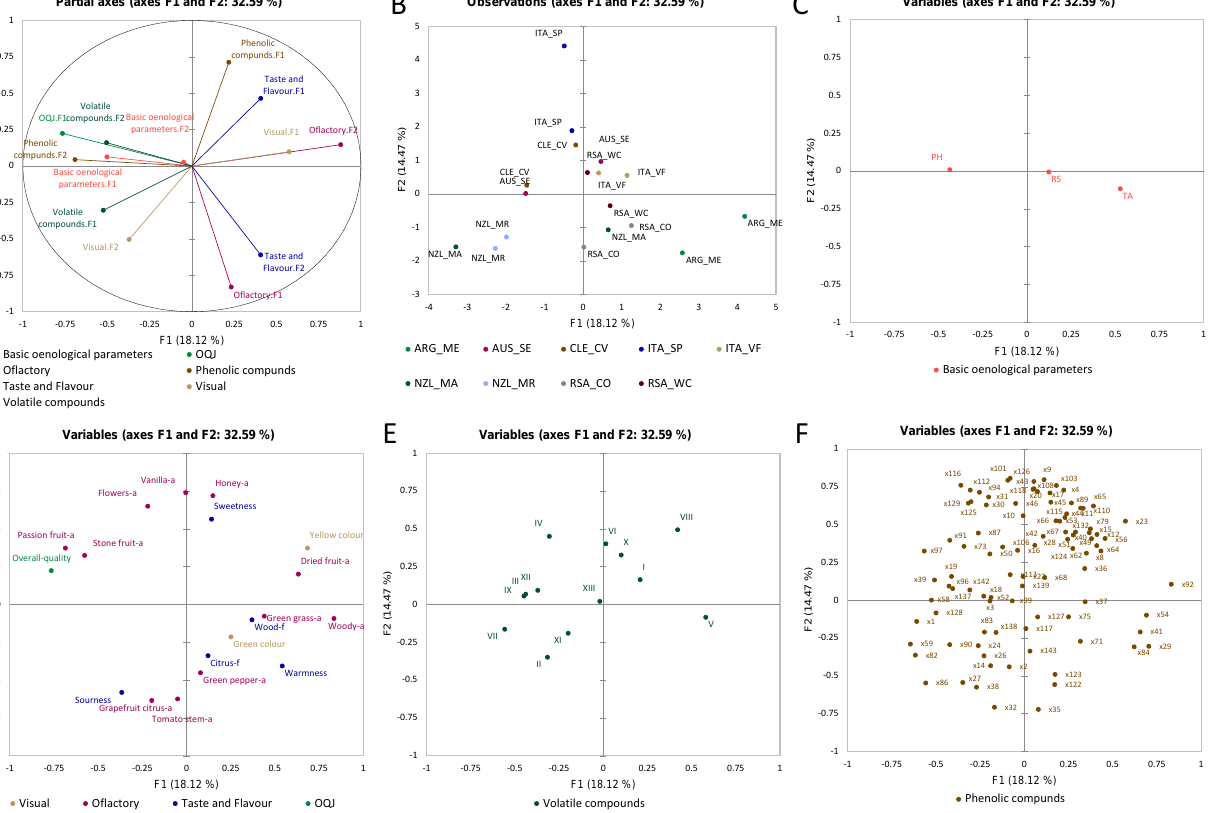
Figure 4. MFA for Sauvignon Blanc dataset. ( A ) shows the partial axes for the first 2 compo- nents and different datasets used in the computation. ( B ) shows the observation plot and ( C – F ) shows basic oenological variables, sensory analysis variables, aroma compounds, and phenolic compounds, respectively. Volatile compounds: I = 1-octen-3-ol, II = 2-sec-butyl-3-methoxypyrazine, III = 3-mercapto-hexanol, IV = 3-mercapto-hexyl acetate, V = 4-mercapto-4-methyl-2-pentanone, VI = acetic acid, hexyl ester, VII = benzaldehyde, VIII = butanoic acid, ethyl ester, IX = ethyl cinna- mate, X = furfuryl mercaptan, XI = trans-2-nonenal, XII = a-terpineol, XIII =